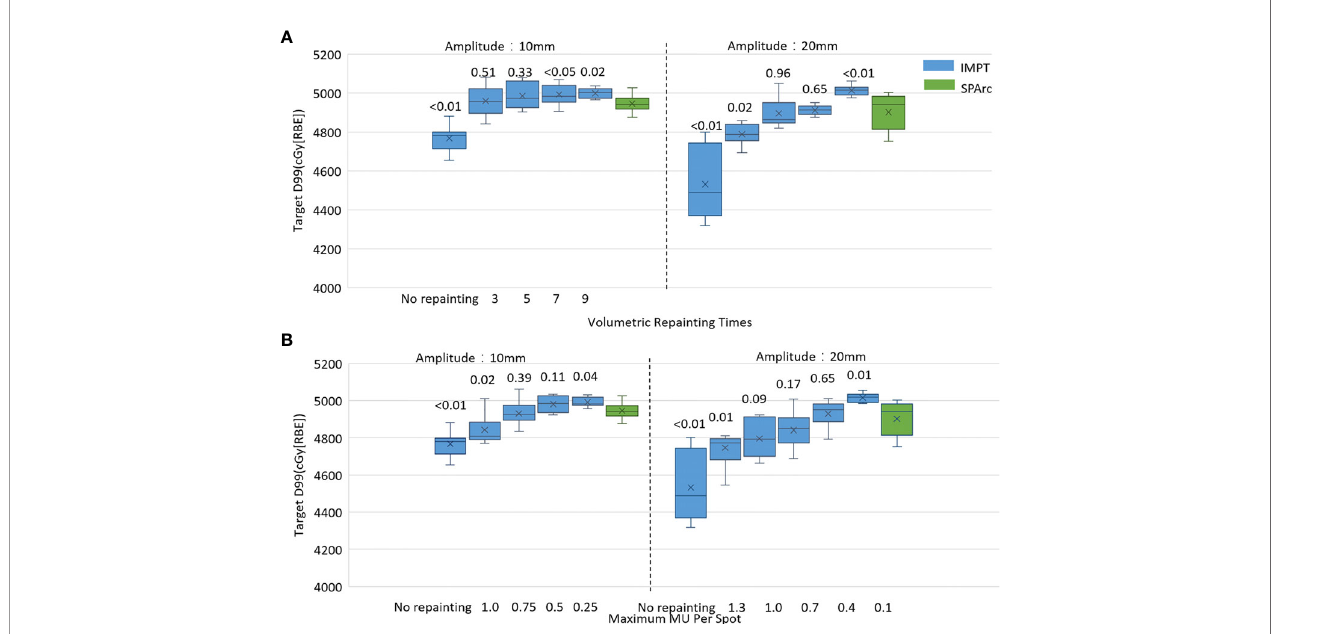
FIGURE 2 | Single fraction 4D dynamic dose comparison between SPArc (green) and (A) different number of volumetric repainting times IMPT volumetric, and (B) IMPTlayer with different maximum MU per